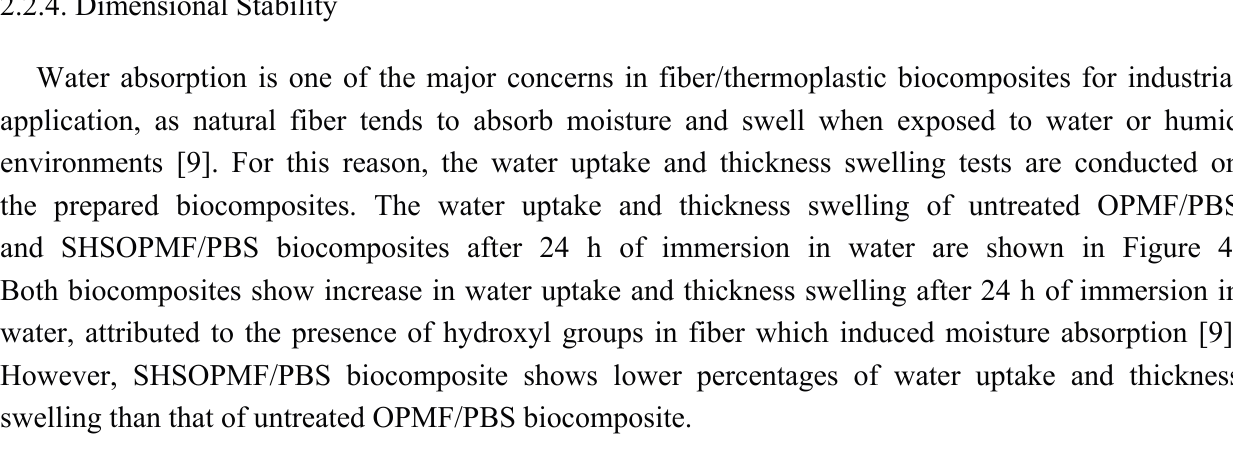
Figure 4. The water uptake and thickness swelling of untreated OPMF/PBS and SHSOPMF/PBS